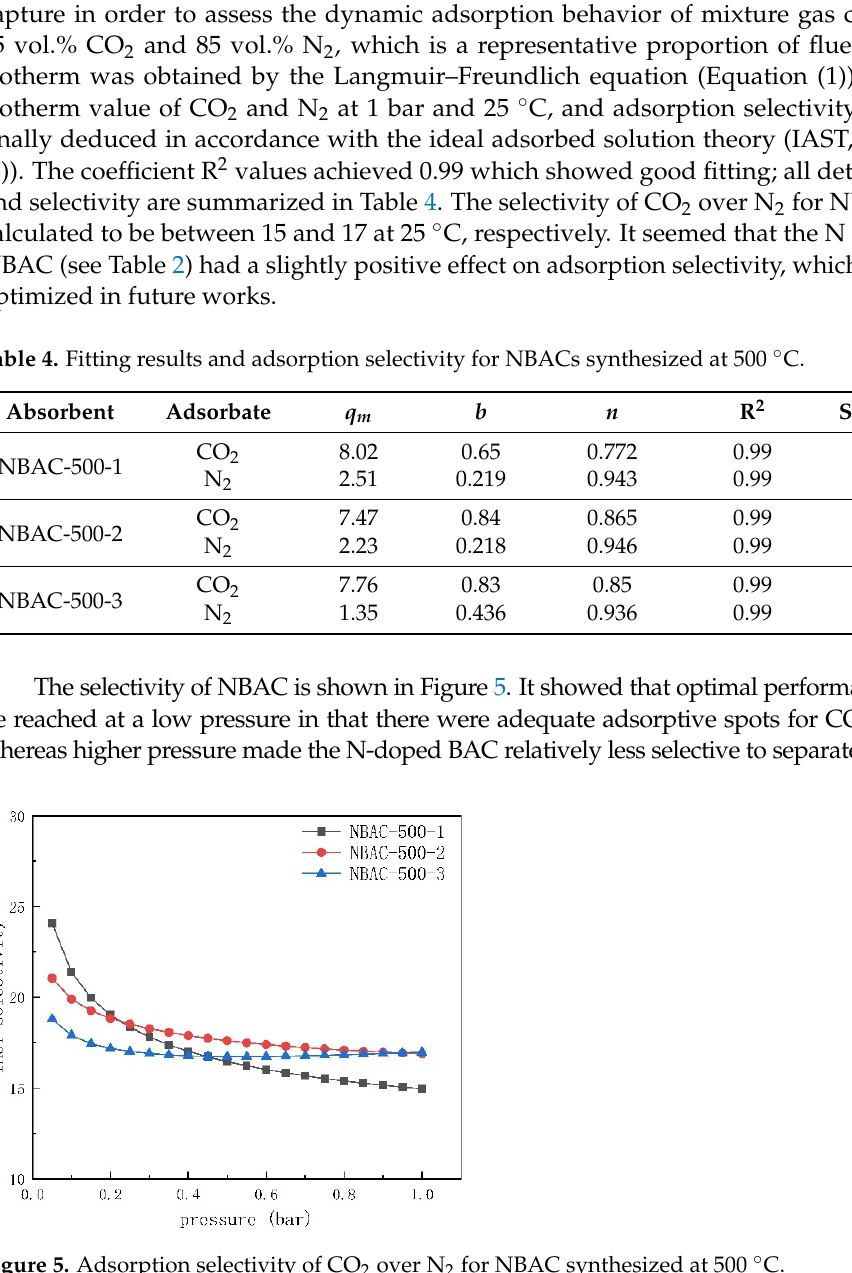
Figure 5. Adsorption selectivity of CO 2 over N 2 for NBAC synthesized at 500